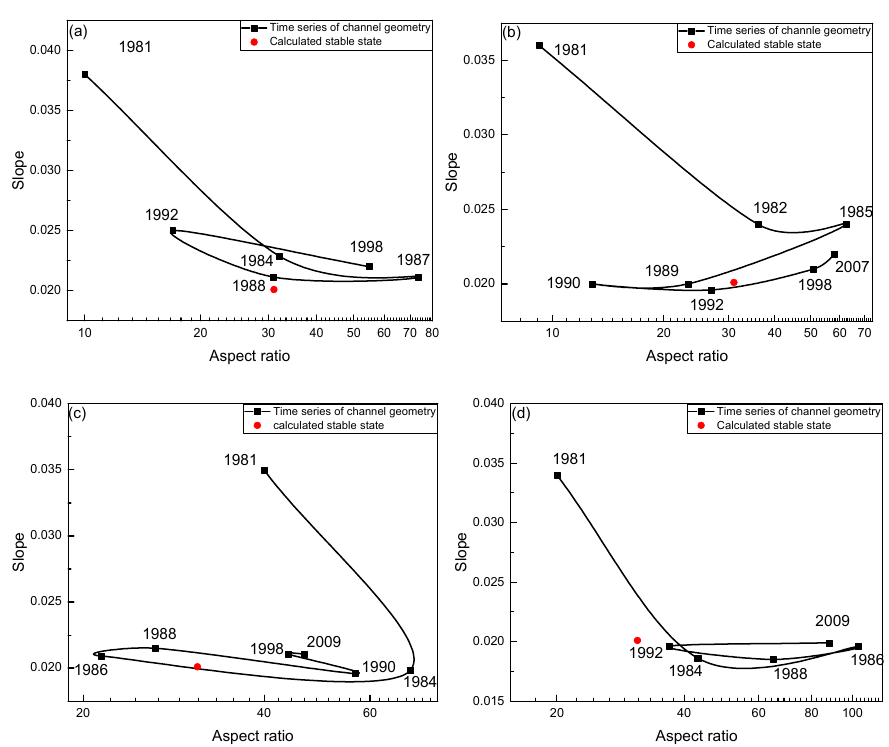
Figure 10. Time series of channel geometries for cross sections NF120, NF130, NF300, and NF310. ( a ) Time series of channel geometries for NF120 from 1981 to 1998; ( b ) time series of channel geometries for NF130 from 1981 to 2007; ( c ) time series of channel geometries for NF300 from 1981 to 2009; ( d ) time series of channel geometries for NF310 from 1981 to 2009.